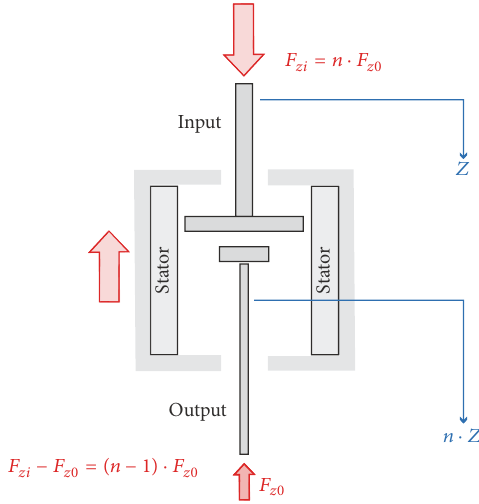
Figure 2: Scheme of the sum of forces applied by 𝑍